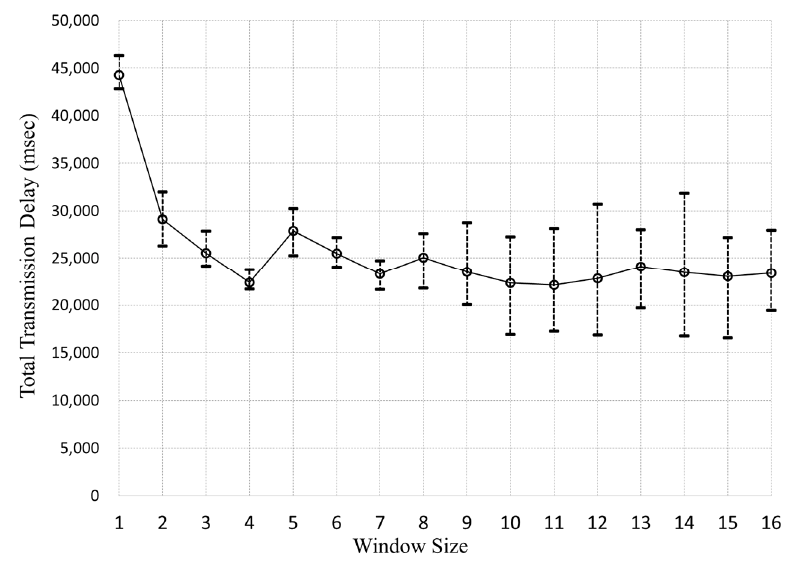
Figure 26. Total transmission delays for different window sizes.